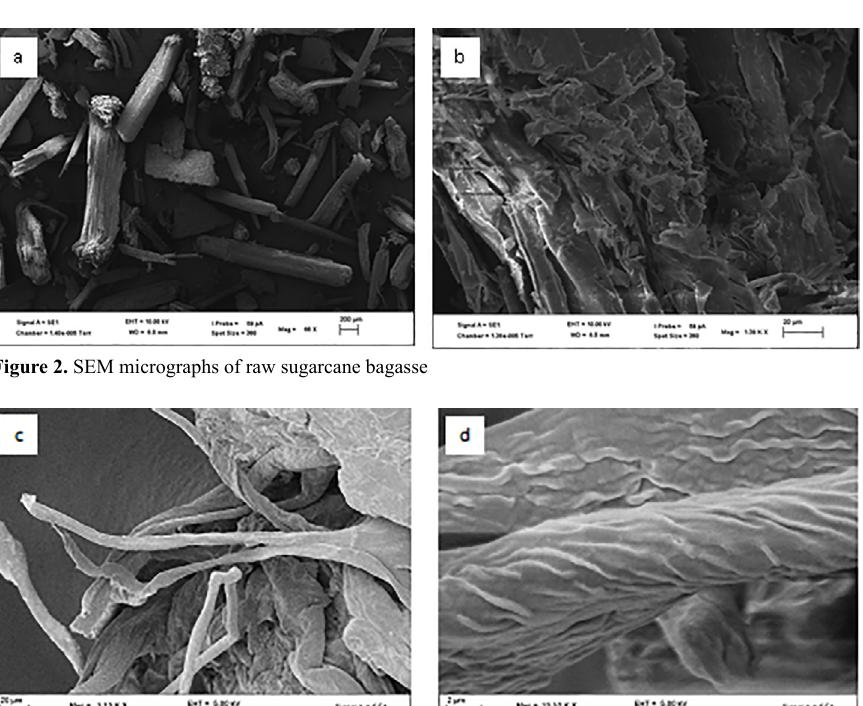
Figure 1. OM images of methods 1(a), 2(b), 3(c), 4(d), and 5(e)